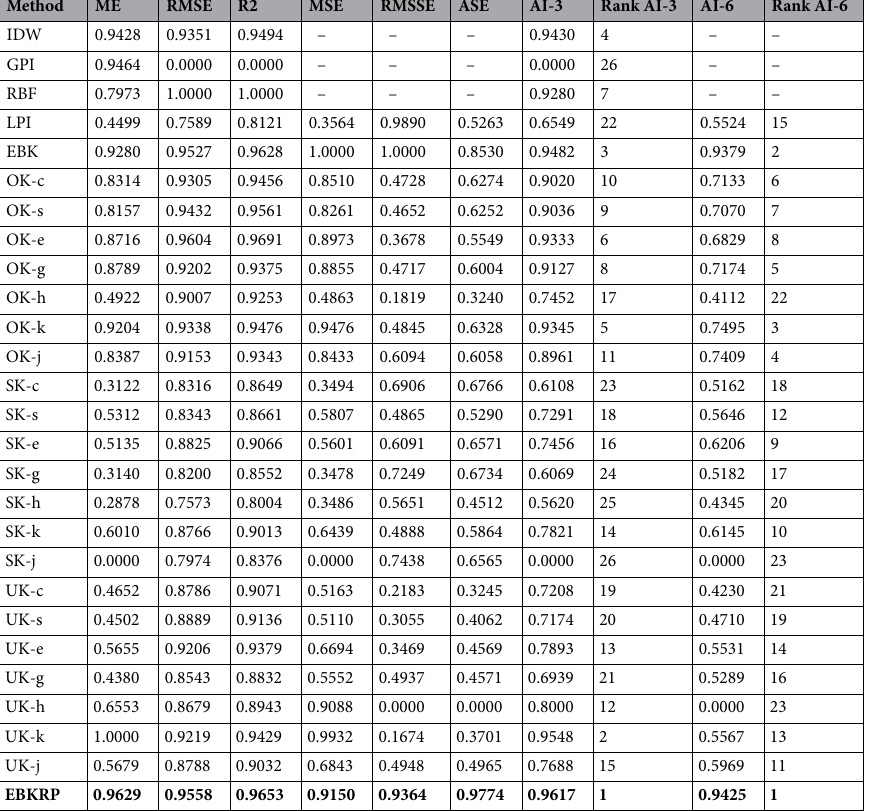
Table 2. Cross-validation statistics from all interpolation methods and the appropriateness index (AI). AI-3 represents the first step of evaluation whereas AI-6 represents the second step of evaluation of the